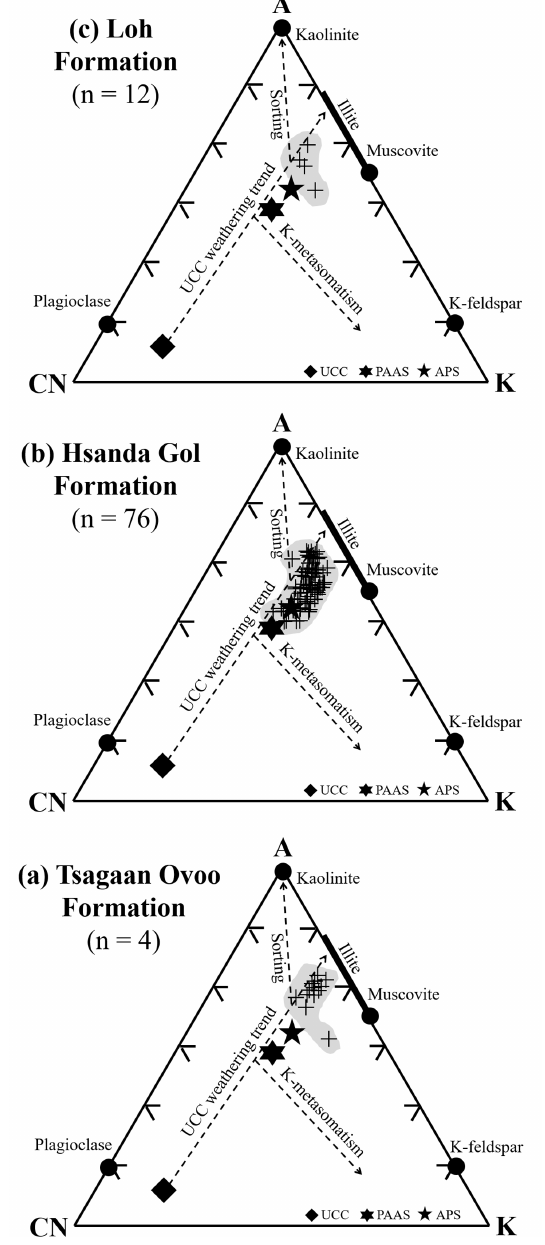
Figure 6. Al 2 O 3 – (CaO ∗ + Na 2 O) – K 2 O (A–CN–K) ternary di- agram of Nesbitt and Young (1984) showing the compositional ranges of sediments from the Valley of Lakes, from the bottom to the top, from (a) the upper-Eocene Tsagaan Ovoo Formation, (b) the Oligocene Hsanda Gol Formation and (c) the lower-Miocene Loh Formation. Note that most samples are shifted to the K pole of the diagram, which indicates a post-depositional enrichment of K 2 O due to illitization. The composition of upper continental crust (UCC), average Proterozoic shale (APS) and post-Archean Aus- tralian shale (PAAS) are included for comparison.